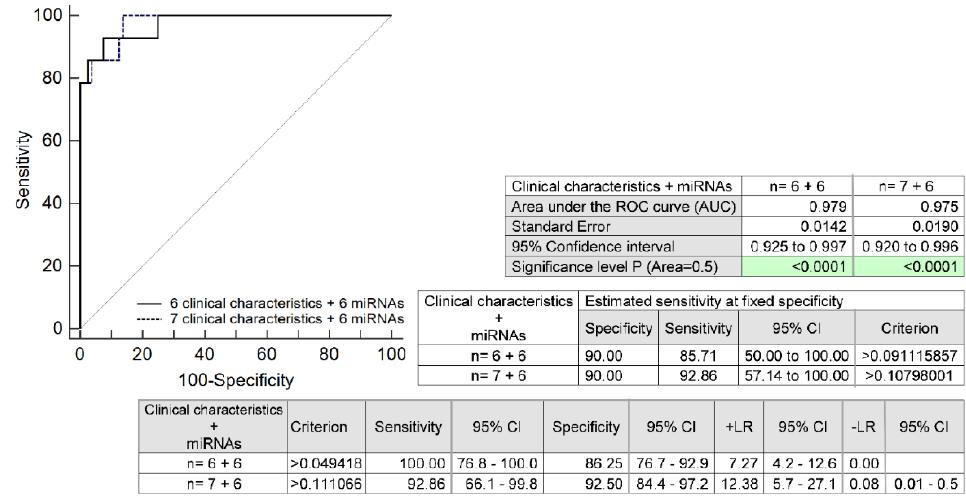
Figure 4. ROC analysis: the combination of six microRNAs (miR-1-3p, miR-17a-5p, miR-143a-3p, miR-146a-5p, miR-181a-5p, and miR-499a-5p) and six maternal clinical characteristics (maternal age and BMI values at early gestational stages, the presence of any autoimmune disease, an infertility treatment by assisted reproductive technologies, the occurrence of HELLP syndrome and/or PE in a previous gestation, and the presence of mutations in trombophilic genes). In the case of the combination of six microRNA biomarkers and seven maternal clinical characteristics, the positivity of first-trimester PE/FGR screening by FMF was added. With a 10.0% FPR, 85.71% and 92.86% of pregnancies developing HELLP syndrome were correctly identified. CI, confidence interval; +LR, positive likelihood ratio; -LR, negative likelihood ratio; BMI, body mass index; PE, pre-eclampsia; FGR, fetal growth restriction; FMF, Fetal Medicine Foundation; FPR, false-positive rate.